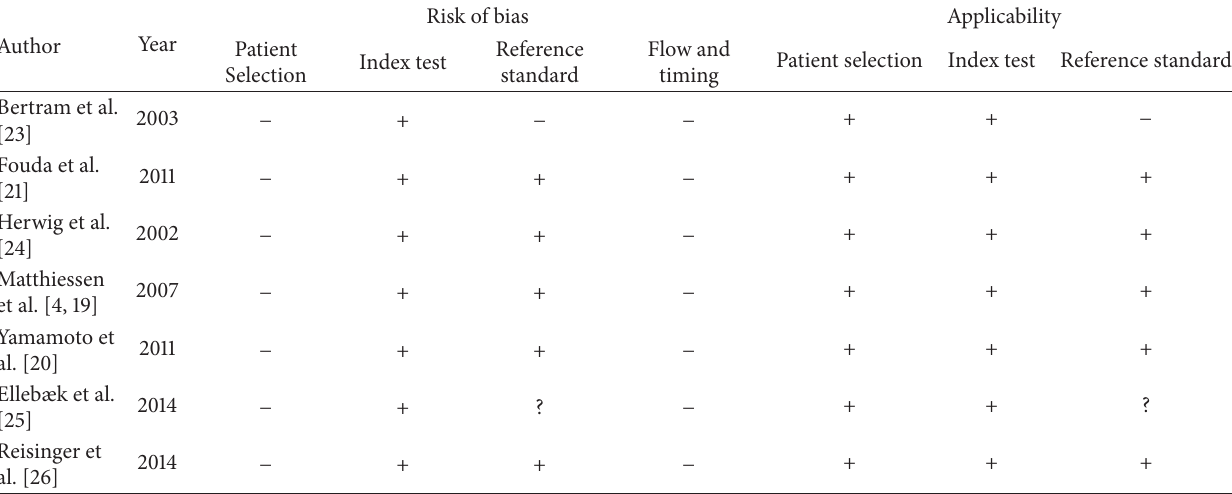
Table 2: Quality assessment of the included studies by judging risk of bias and applicability using Quality Assessment of Diagnostic Accuracy Studies-2 (QUADAS-2). +: low risk of bias; − : high risk of bias; ?: not specified.